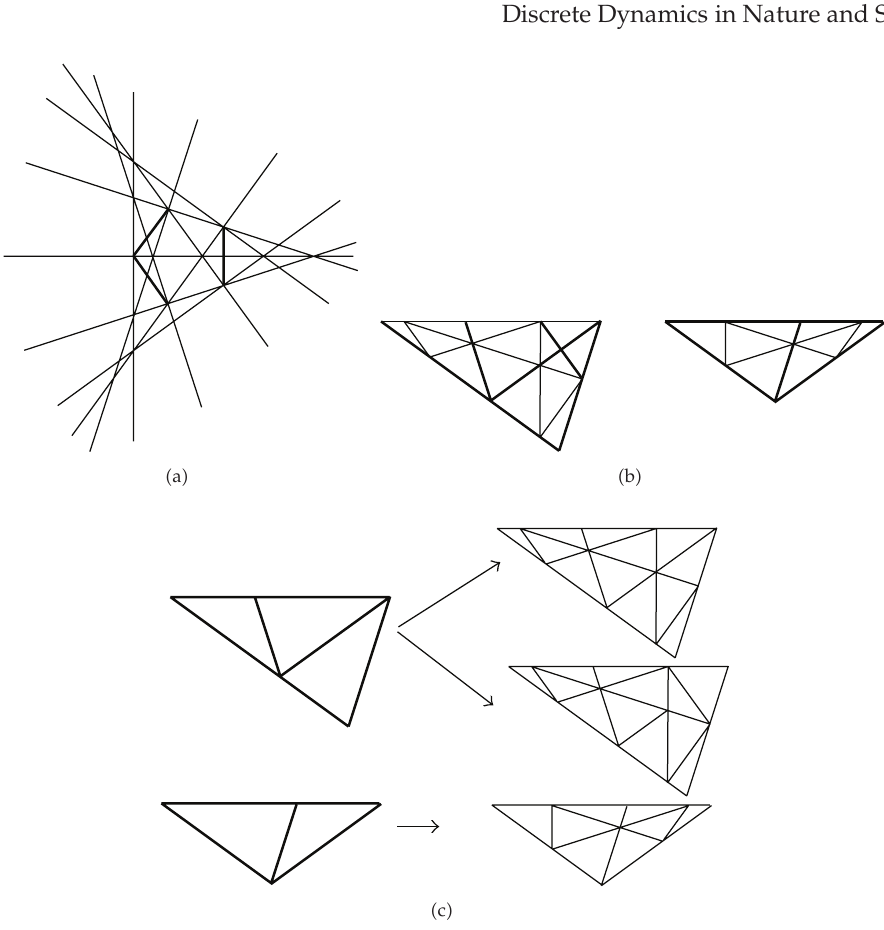
Figure 6: (cid:6) a (cid:7) The 10-system with thick lines indicating flipped edges. (cid:6) b (cid:7) The first inflation step corre- sponding to d (cid:5) 5 is indicated by thick lines; prototile subdivision by the 10-system is represented with thin lines and the thicker line indicates the possible tile flip. (cid:6) c (cid:7) First inflation step followed by prototile subdivision and the two possibilities of subdividing one of the